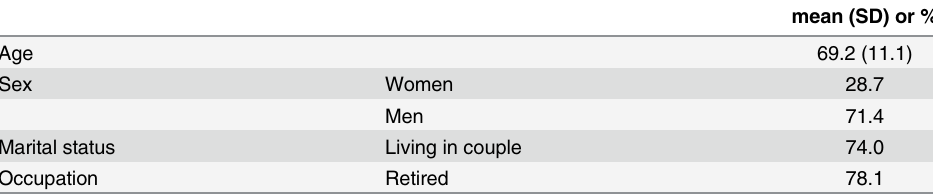
Table 1. Sociodemographic characteristics of the sample.